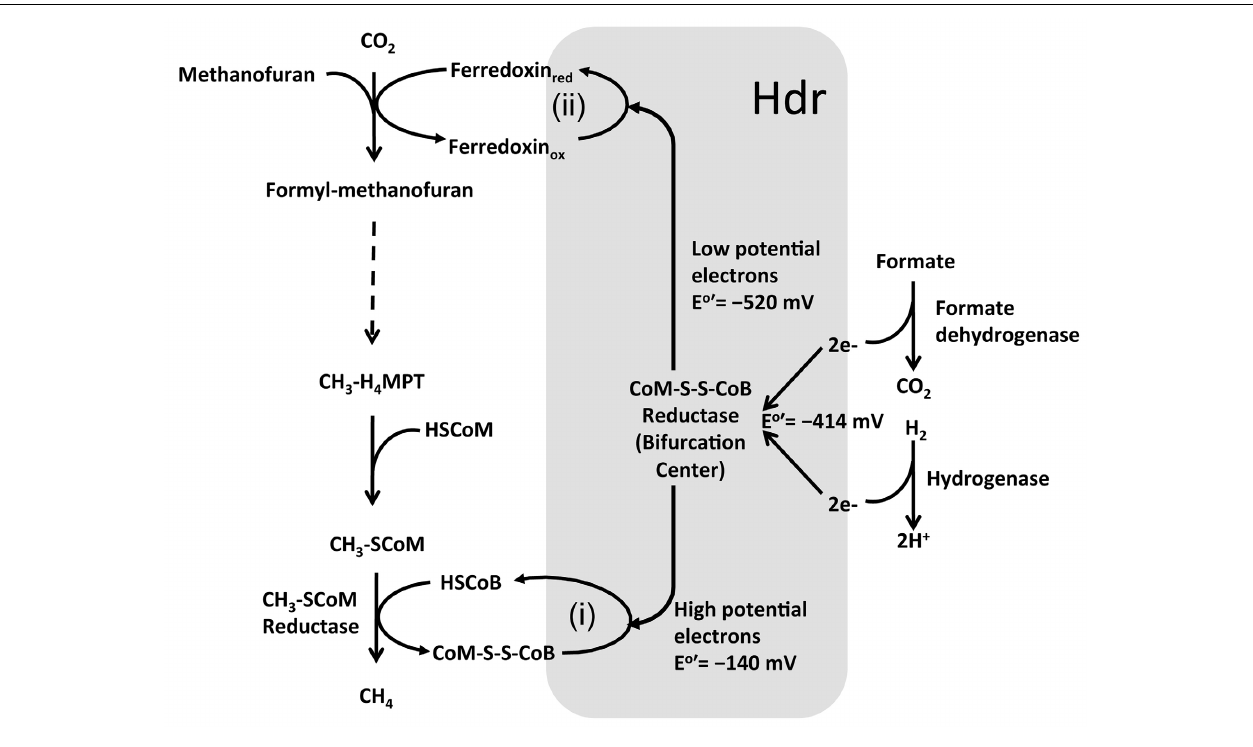
FIGURE 5 | Electron bifurcation in Methanogenesis. HS-CoB or HS-HTP, coenzyme B; HS-CoM, coenzyme M; CoM-S-S-CoB, heterodisulfide of coenzymeM and coenzyme B. Heterodisulfide reductase (Hdr) utilizes bifurcated energy electrons for two purposes: (i) converting CoM-S-S-CoB to